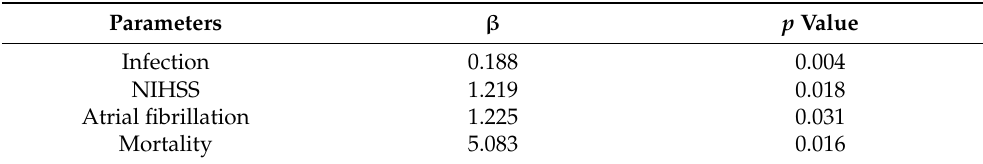
Table 5. Logistic regression analysis between PNI and clinical parameters in patients with acute ischemic